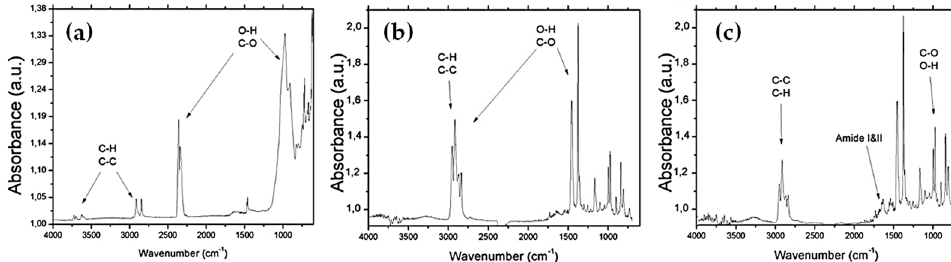
Figure 3. FTIR spectrum of the PET sample before radiofrequency cold plasma treatment ( a ); after plasma treatment ( b ); after 1018K6 bio-conjugation ( c ).